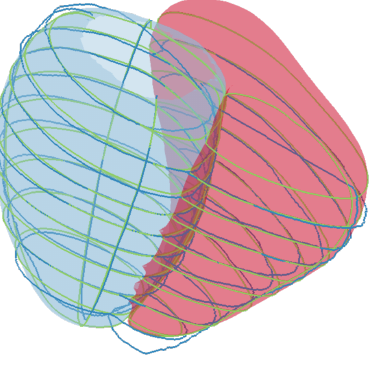
Figure 1. An example of the SSM of the left ventricle epicardium and right ventricle endocardium fitted to real contours. The dark blue contours represent the real contours. The green contours represent the synthetic contours generated by slicing the SSM at the same spatial pose of the CMR acquired contour